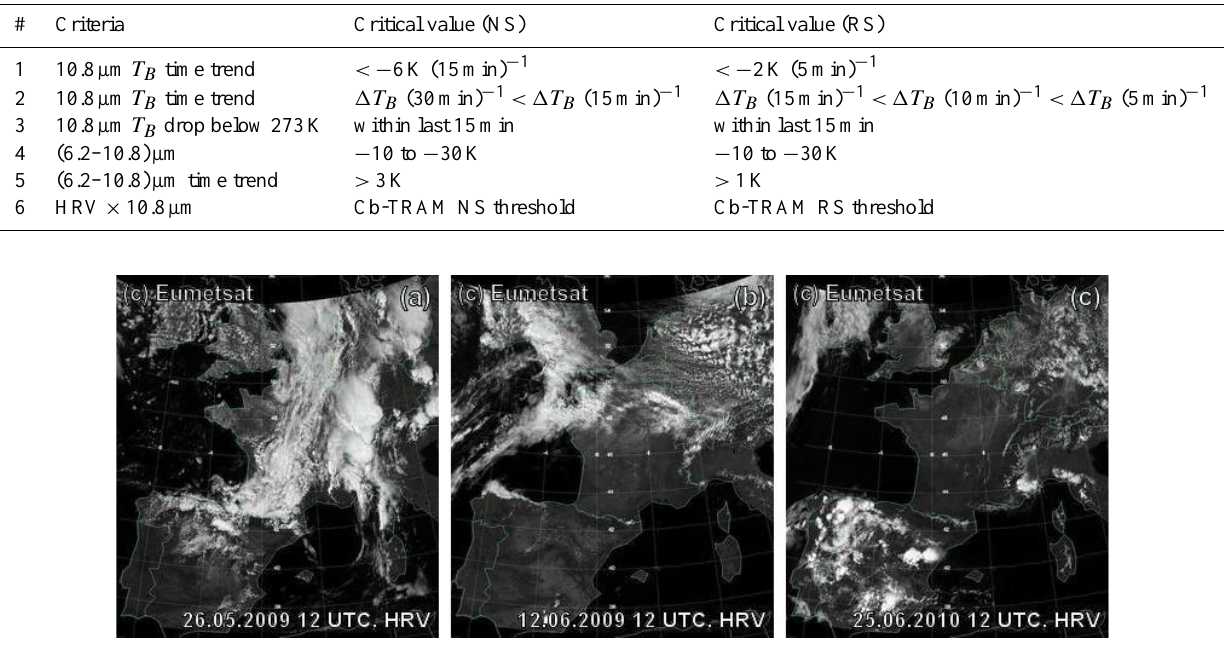
Fig. 3. High-resolution visible (HRV) Meteosat images representative for the synoptic classes (a) “cold front” on 26 May 2009, (b) “cold air” on 12 June 2009, (c) “high pressure” on 25 June 2010,